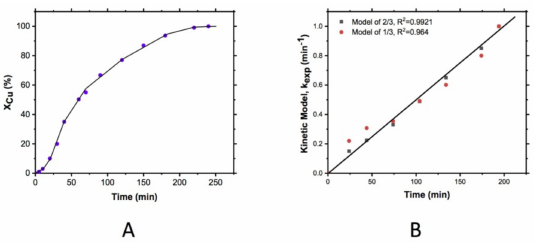
Figure 3. ( A ) Type S curve for the Cu leaching and ( B ) treatment of leaching data with the kinetics models of 1/3 [1 − (1 − X Cu ) 1/3 ], and 2/3 [1 − 3(1 − X Cu ) 2/3 + 2 (1 − X Cu )].